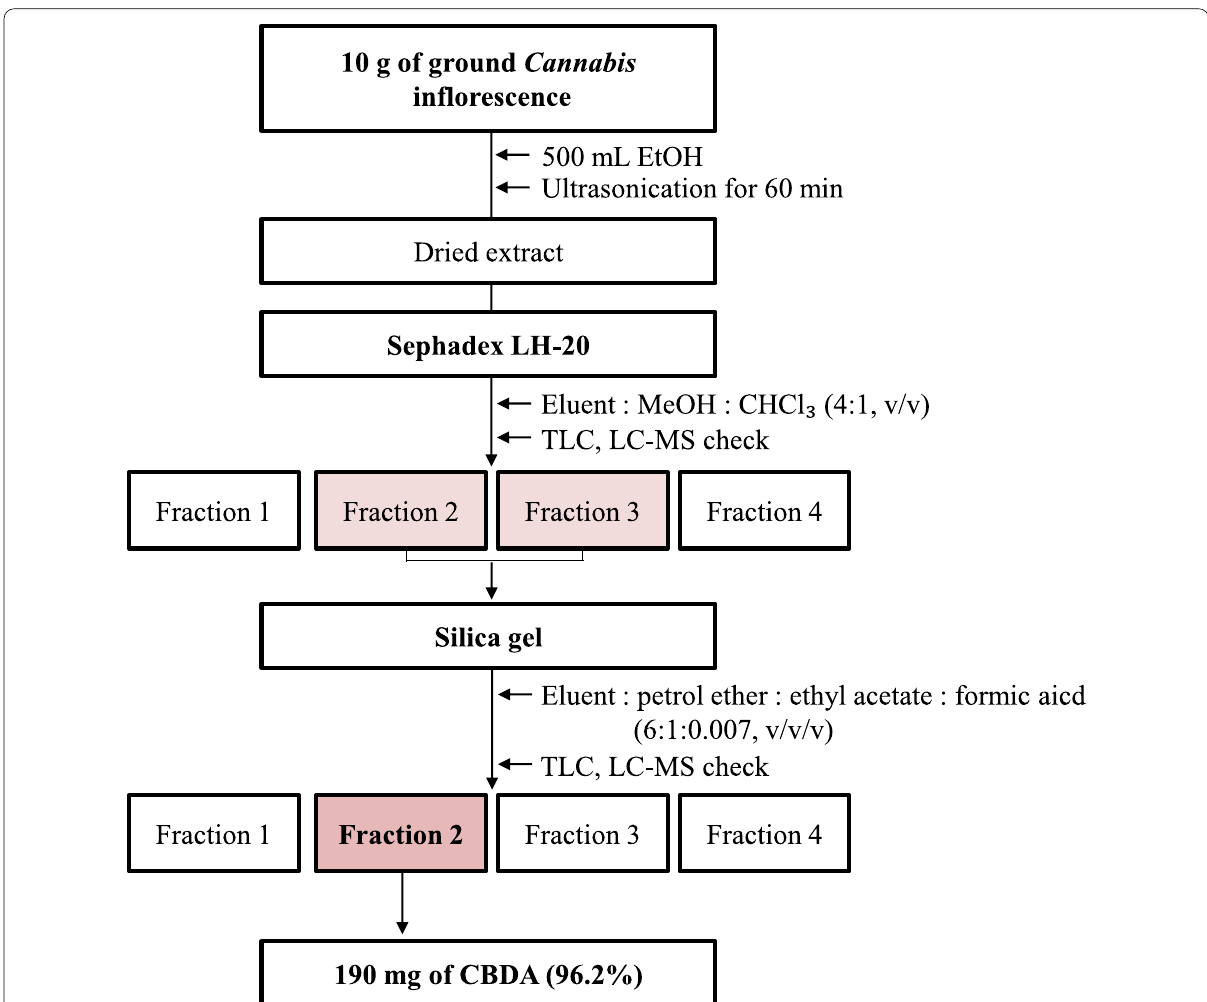
Fig. 2 Flow of isolation of CBDA from extract of Cannabis